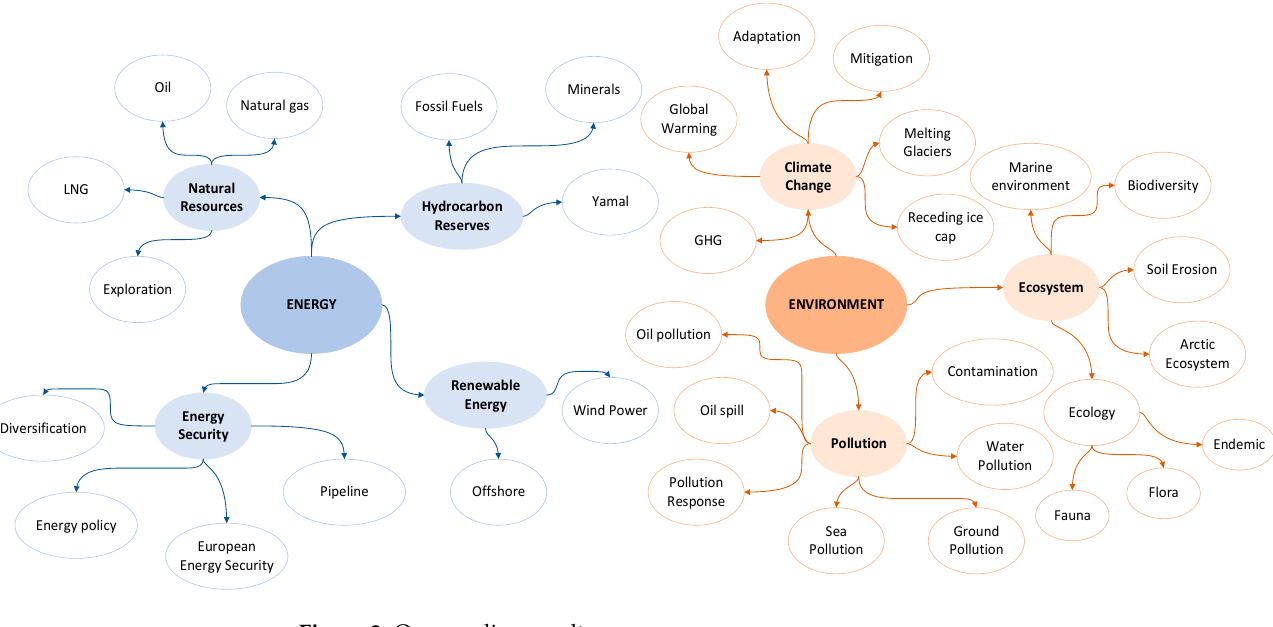
Figure 2. Open coding results.